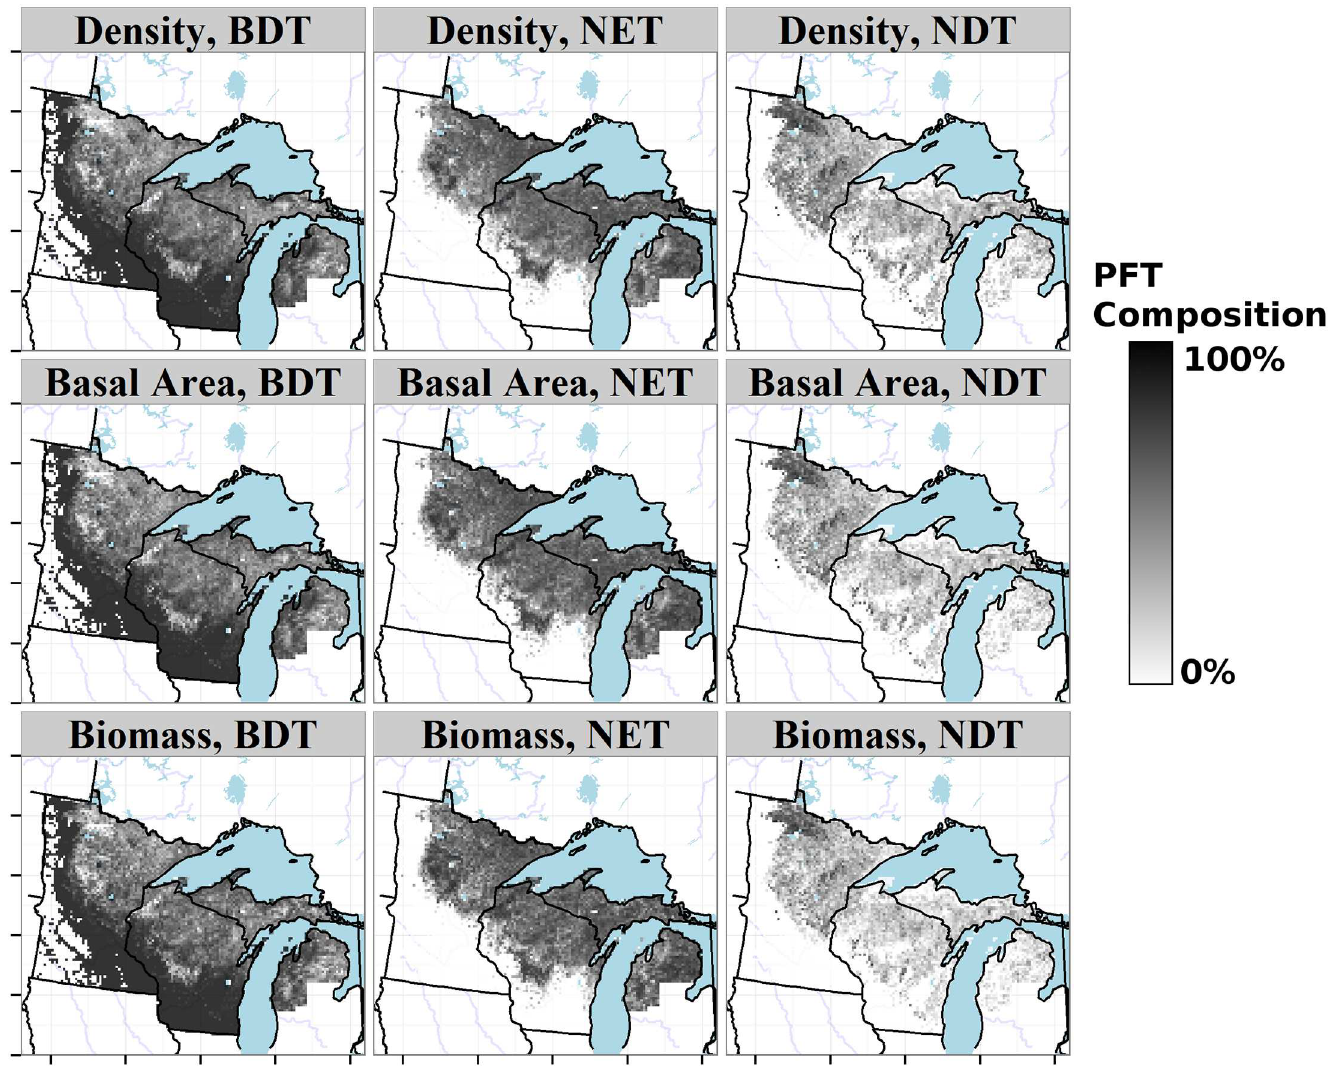
Fig 6. Proportional distribution of Plant Functional Types (PFTs) in the upper Midwest from PLSS data. Broadleaveddeciduous tree (BDT), needleleaved deciduous tree (NDT), and needleleaved evergreentree (NET) distributions are shown as proportions relative to total basal area, total biomass, and composition(Fig 2). The grasslandPFT is mappedonto non-treecells with the assumption that if trees were availablesurveyorswould have